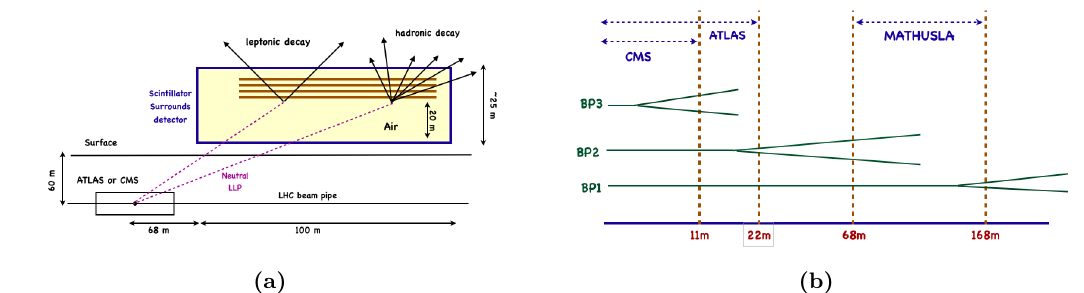
Figure 7. A schematic diagram for MATHUSLA detector [68] and the rest decay points of chosen